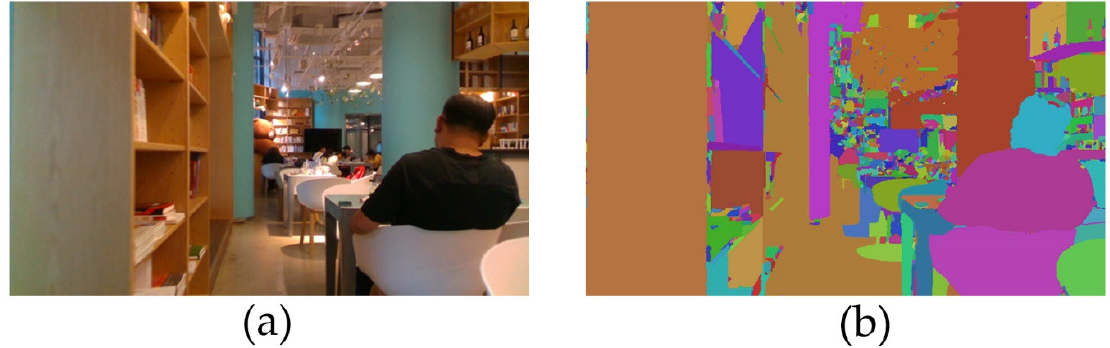
Figure 3. OpenLORIS-Scene Datasets: cafe scene: ( a ) RGB image; ( b ) segmentation of the RGB